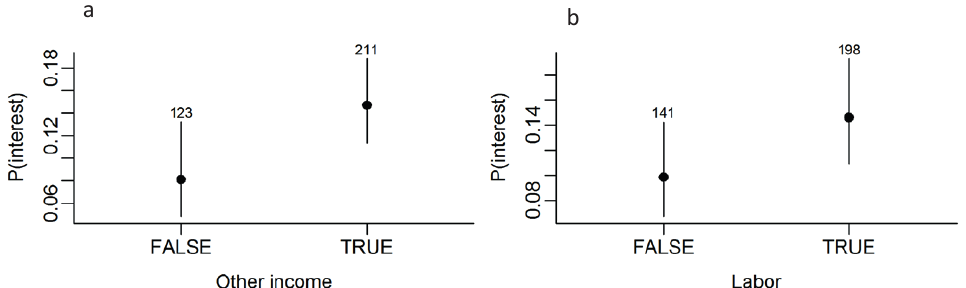
Fig. S2. Probability of interest in organic production with 95% confidence interval for farmers with and without other sources of income (a) and for those using or not using hired labor, and the number of farmers in each